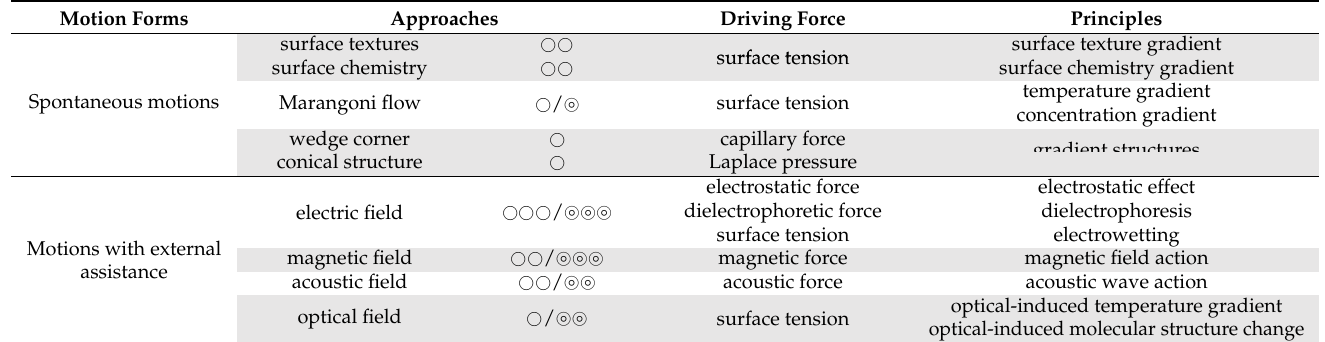
Table 1. The approaches, driving force, and principles in both the spontaneous motions and external- field actuated motions of bare droplets and LMs (note: Different quantities of “ the relative capacity of various approaches in actuating bare droplets and LMs,